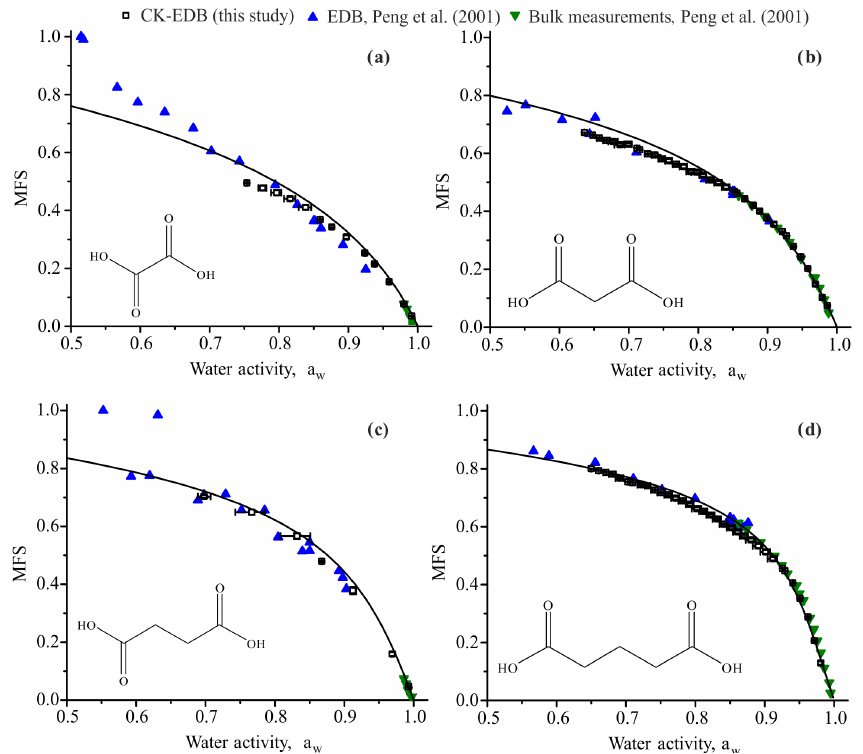
Figure 3. Hygroscopicity of dicarboxylic acid droplets measured with the CK-EDB (open black squares) compared with the EDB data of Peng et al. (2001) (upward blue triangles) and bulk measurements (downward green triangles) for (a) oxalic acid, (b) malonic acid, (c) succinic acid and (d) glutaric acid. UNIFAC predictions are shown for all compounds (solid black line). UNIFAC prediction using